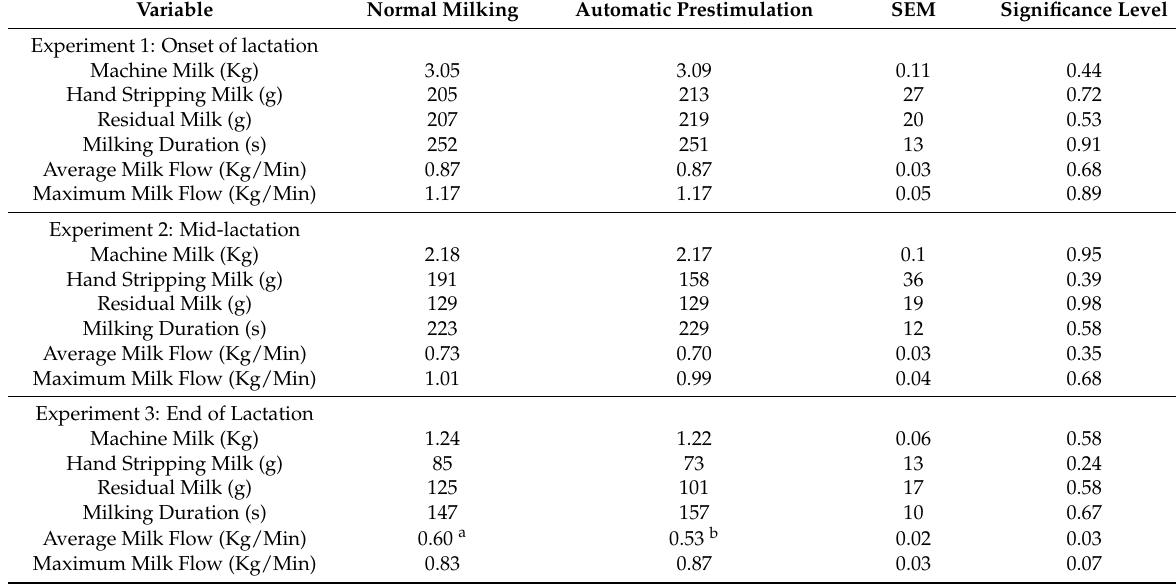
Table 1. Effect of the treatment (normal milking vs. milking with automatic prestimulation) on variables related to milking efficiency in Murciano-Granadina goats on three moments of the lactation (least square means ± standard error of the mean).